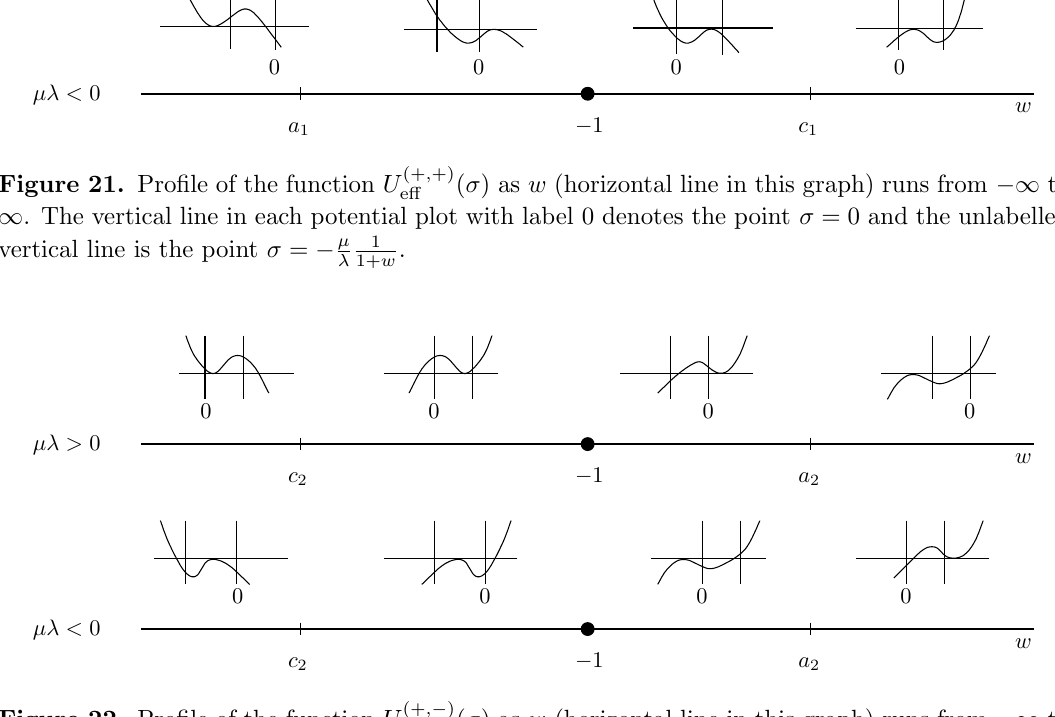
( (cid:27) ) as w (horizontal line in this graph) runs from (cid:0)1 to e(cid:11) 1 . (cid:21) 1+ w